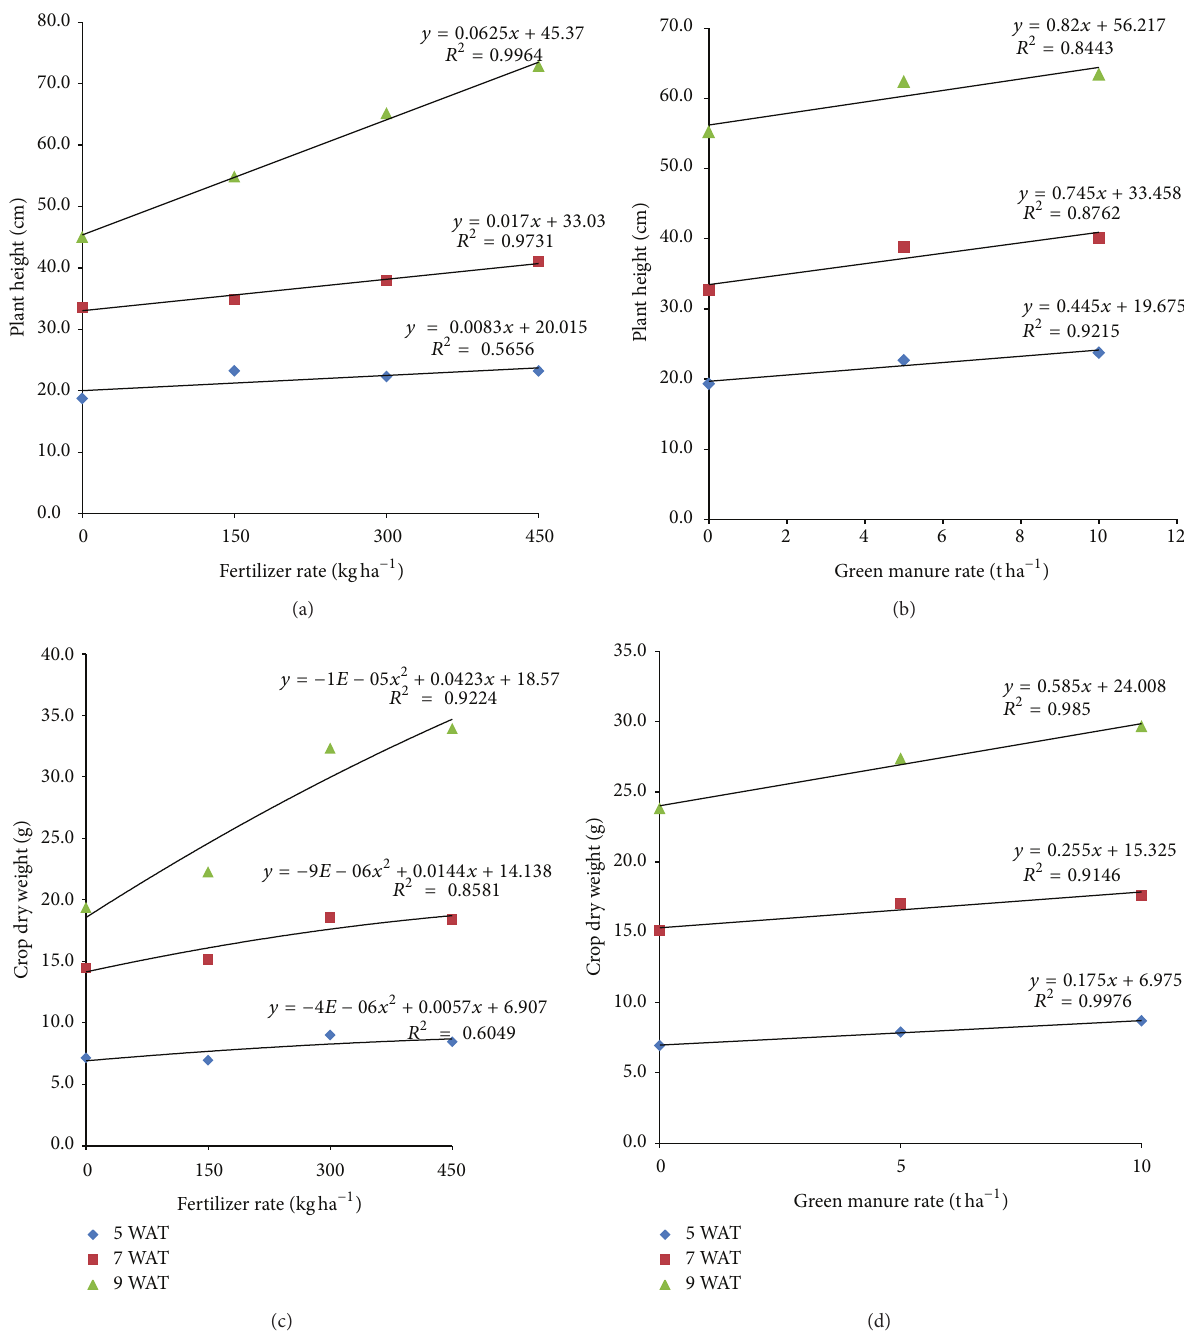
Figure 1: Effect of NPK fertilizer and green manure rate on plant height (a) and (b), crop dry weight (c) and (d) of tomato.